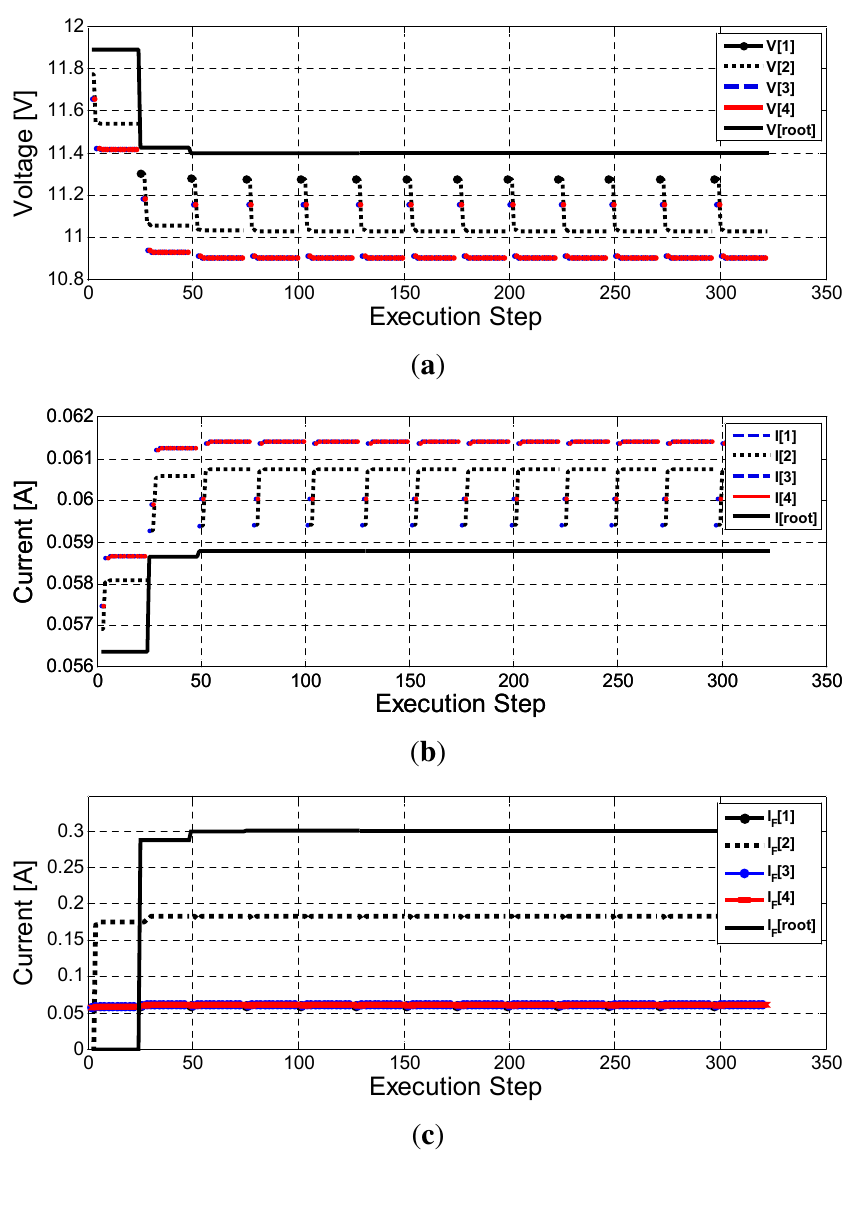
, ( b ) I steps, ( c ) I over execution steps of the example i i F i